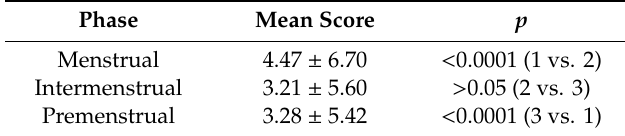
Table 1. Mean scores of the negative a ff ect scale for the menstrual, intermenstrual, and premenstrual phases and the di ff erences among the three